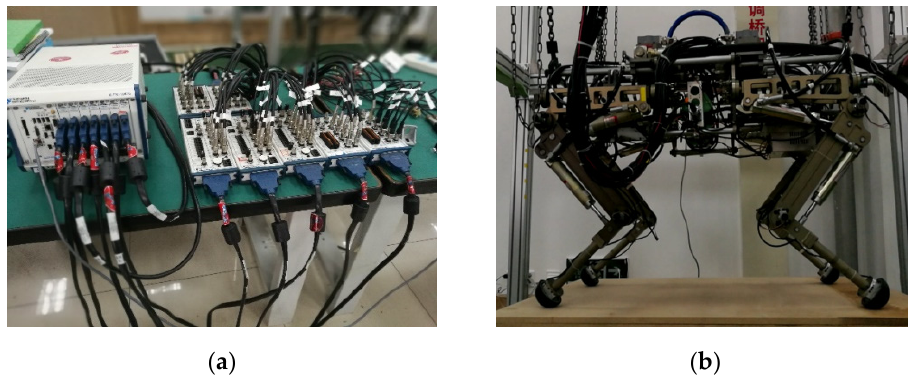
Figure 4. Overview of the hydraulically actuated quadruped robot system. ( a ) National Instrument ® -based controller; ( b ) prototype of the hydraulically actuated quadruped robot.